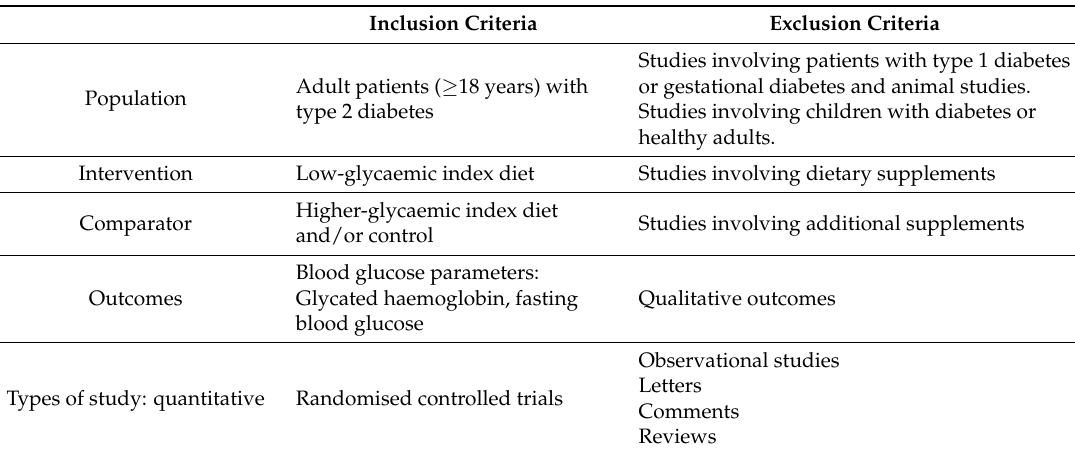
Table 2. Criteria for considering studies for the review based on the Population, Intervention, Comparator, Outcomes and Study designs (PICOS)